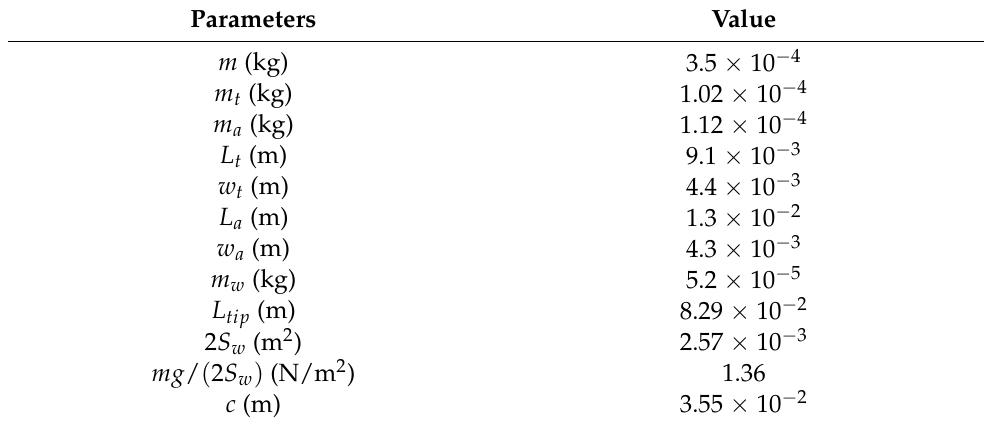
Table 1. Morphological parameters of the butterfly ( Chilasa clytia